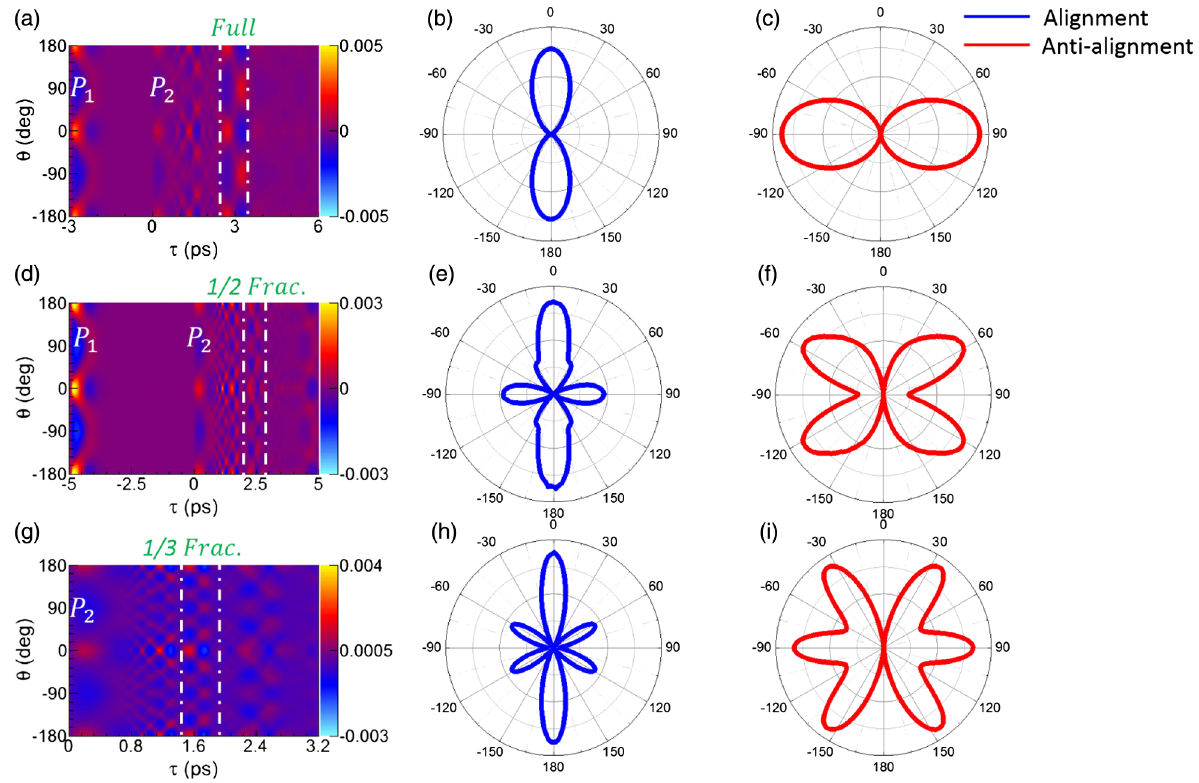
FIG. 10. Classical simulation of time-dependent angular distributions of full, 1 = 2 , and 1 = 3 echoes. (a) Angular distribution of full echo in the case of a parallel condition with a time delay of 3 ps between P 1 and P 2 . (b,c) Alignment and anti-alignment of full echo in polar plots. Panels (d) – (f) and (g) – (i) show the same for 1 = 2 and 1 = 3 fractional echoes with a time delay of 5 ps between P 1 and P 2 ,